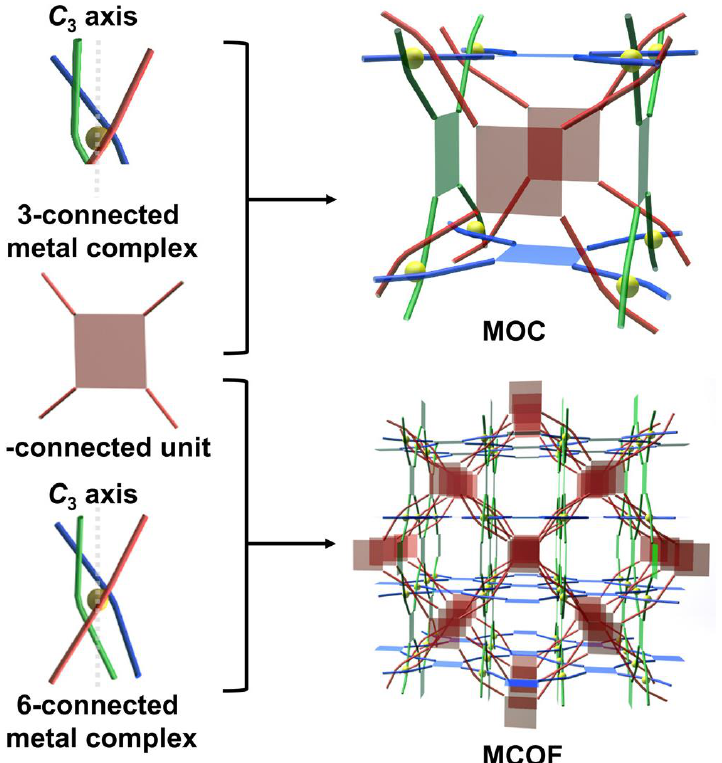
Figure 9. Conversion strategy of metal-organic cages to 3D COFs [34].